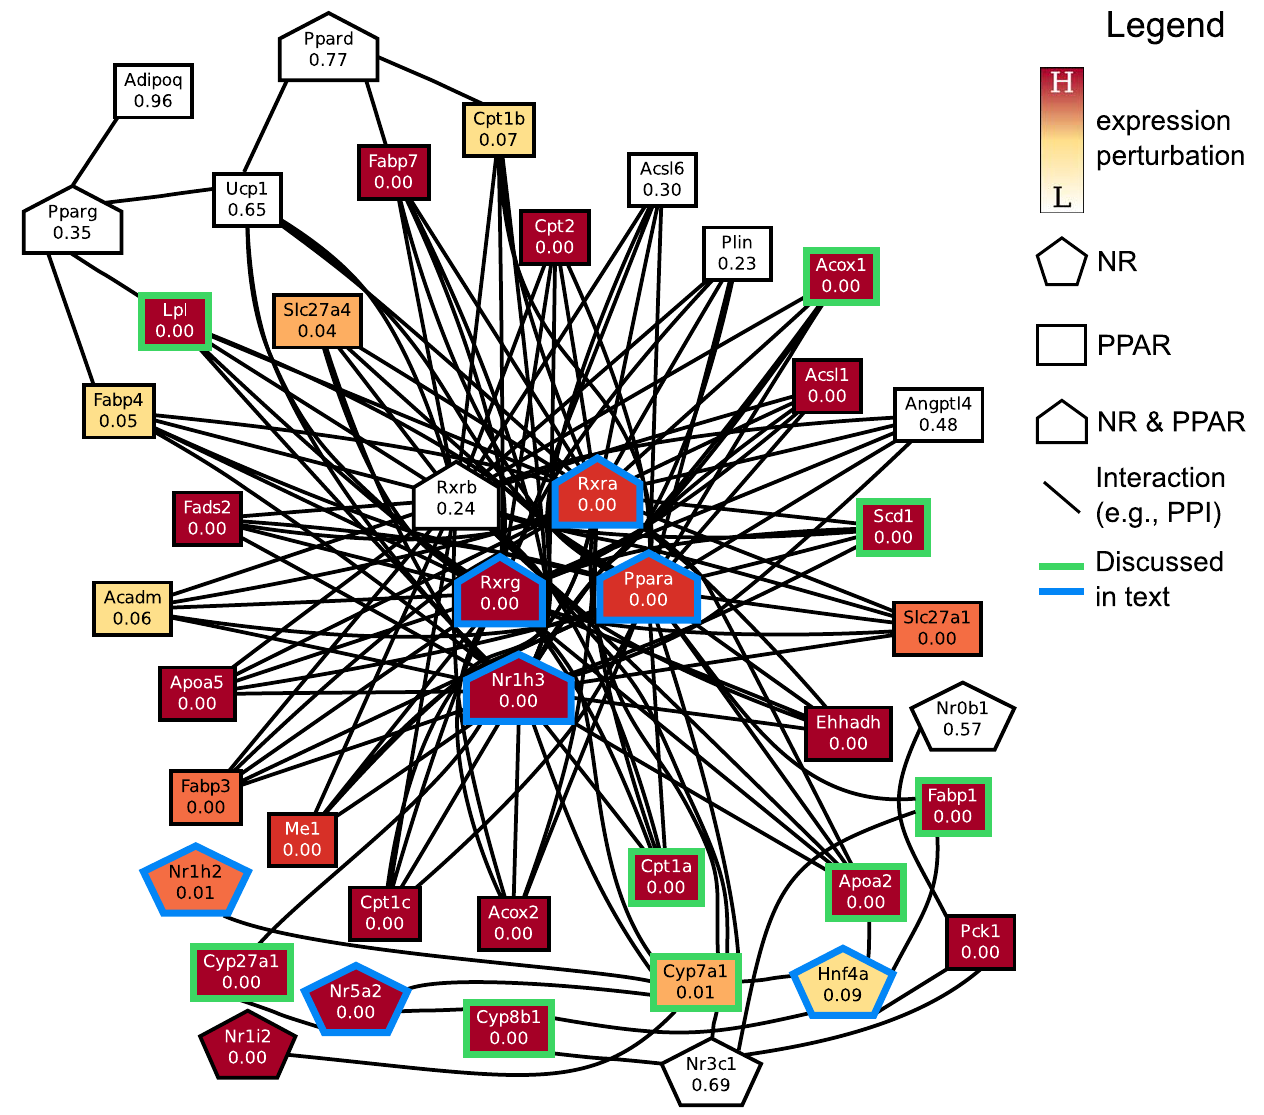
Figure 9. Network of functional interactions resulting in the link between NUCLEAR_RECEPTORS and HSA03320_PPAR_SIGNA- LING_PATHWAY on day 8. Abbreviations: NR: annotated with NUCLEAR_RECEPTORS, PPAR: annotated with HSA03320_PPAR_SIGNALING_ PATHWAY.